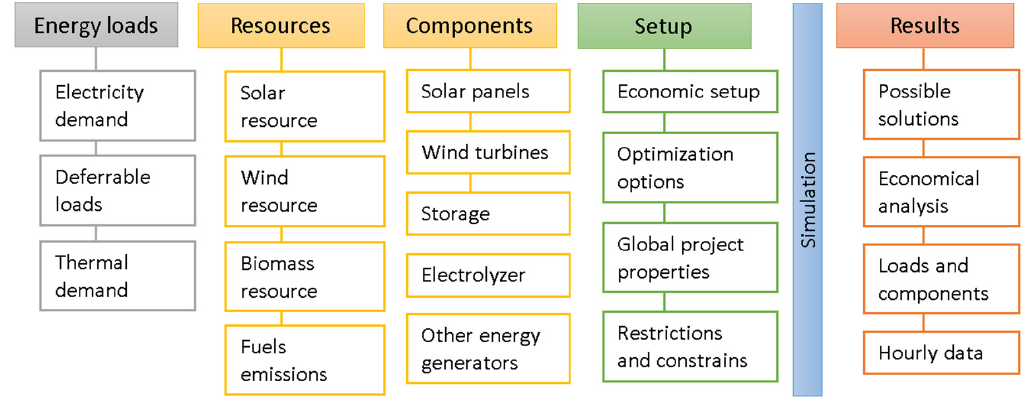
Figure 1. Schematic overview of the HOMER software information of inputs and outputs.